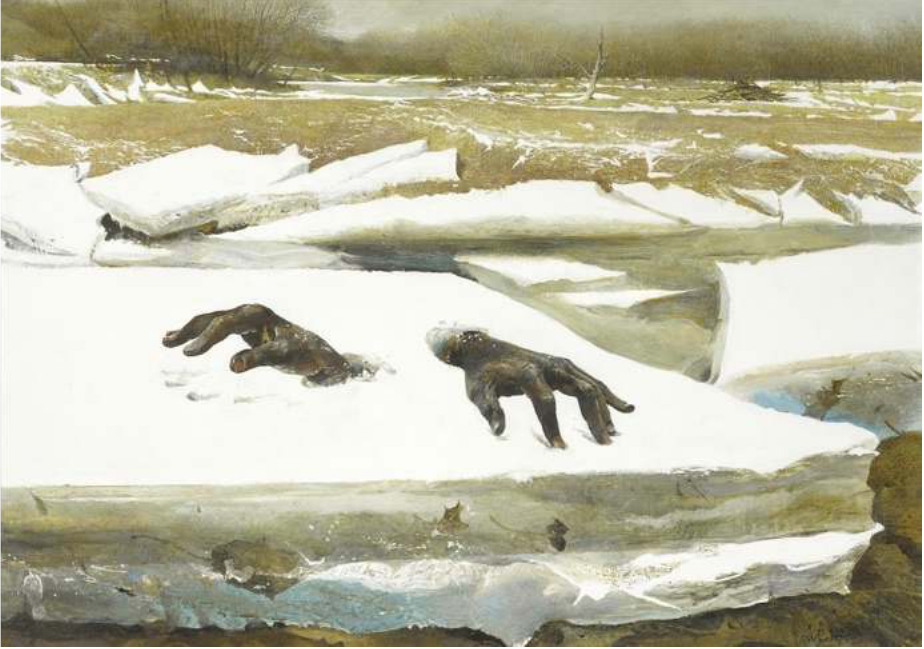
Figure 19. Andrew Wyeth, Breakup. Tempera on panel